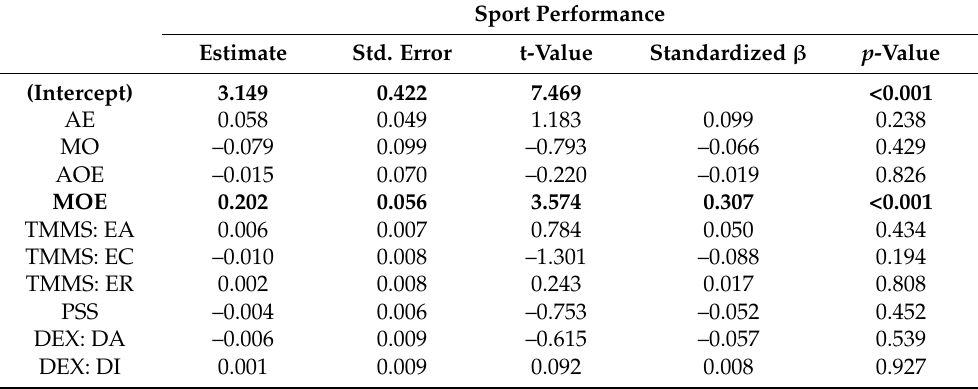
Table 6. Regression